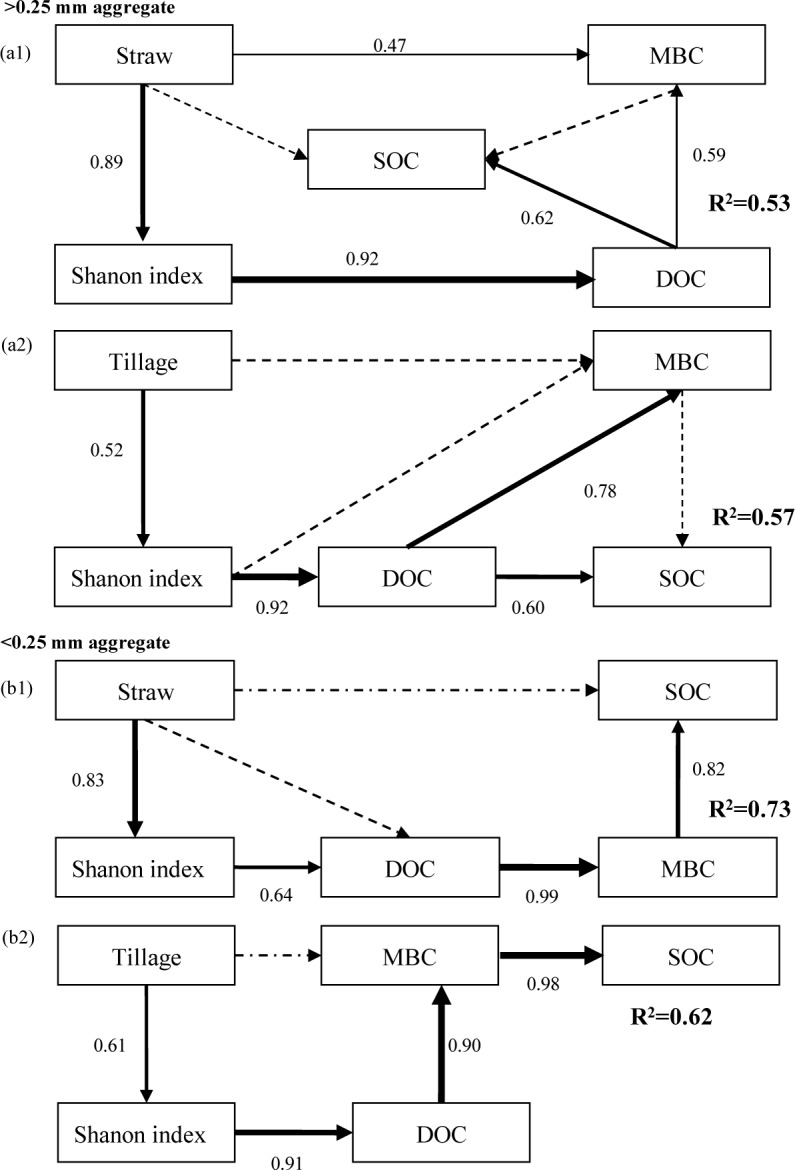
Structural equation modelling relating tillage systems, residue returning and microbial metabolic diversity to SOC in >0.25 mm (a1, χ2 = 2.791, df = 3, p = 0.432, CFI = 1, GFI = 0.920, RMSEA = 0.001; a2, χ2 = 6.163, df = 4, p = 0.617, CFI = 0.957, GFI = 0.978, RMSEA = 0.020) and <0.25 mm aggregates (b1, χ2 = 0.541, df = 4, p = 0.144, CFI = 0.956, GFI = 0.954, RMSEA = 0.010; b2, χ2 = 7.71, df = 4, p = 0.056, CFI = 0.975, GFI = 0.951, RMSEA = 0.020).Rectangles represent observed variables. Arrow thickness represents the magnitude of the path coefficient. Values associated with solid arrows represent the path coefficients. Solid and dashed arrows indicate significant (P<0.05) and non-significant (P>0.05), respectively. Tillage, tillage systems; Straw, straw systems; DOC, dissolved organic C; MBC, microbial biomass C; SOC, soil organic C.